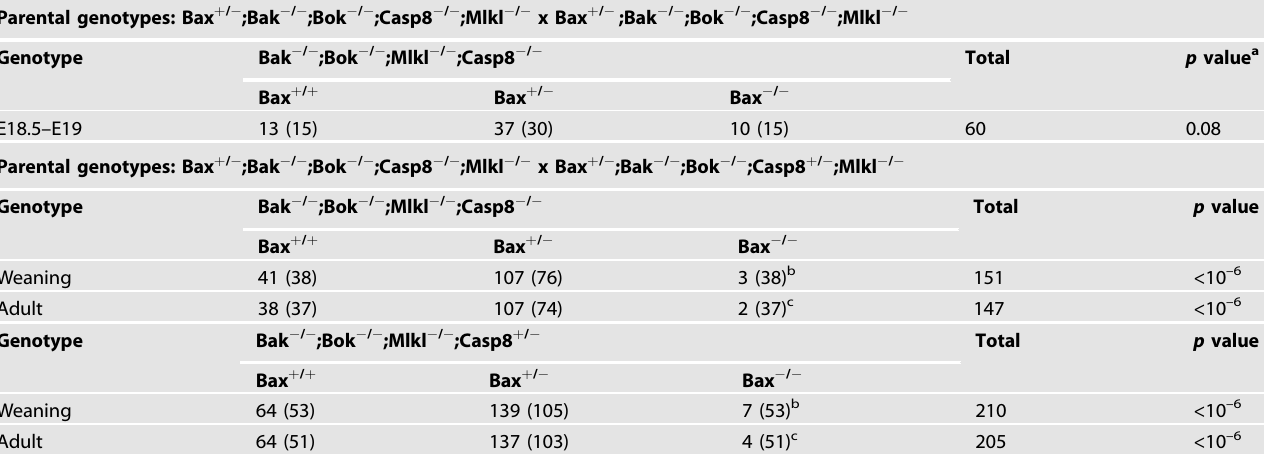
Table 1. Bax − / − ;Bak − / − ;Bok − / − ;Casp8 − / − ;Mlkl − / − quintuple knockout (Q5KO) mice are not produced at the expected Mendelian frequency; nevertheless some can reach weaning (~21 days) and even adulthood ( ≥ 42 days).